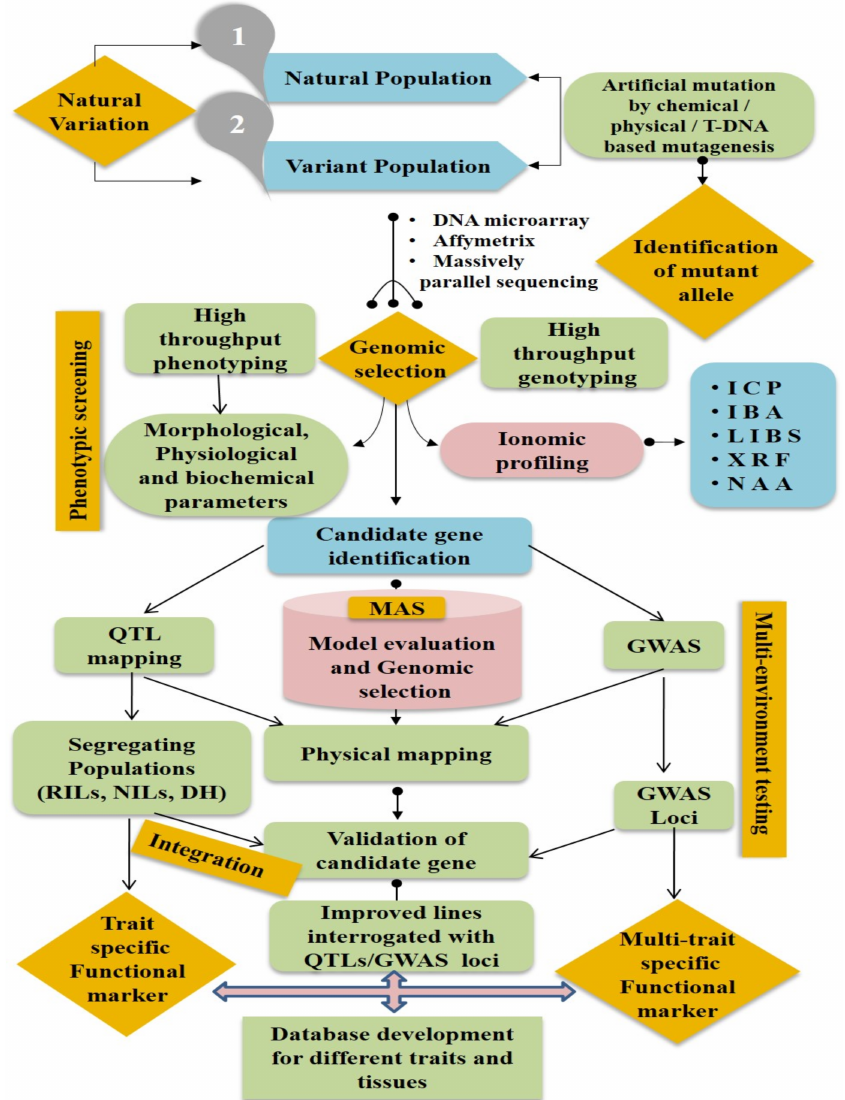
Figure 2. Quantitative trait locus (QTL) mapping and genome-wide association study (GWAS) for the identification of multi-trait specific biomarkers based on ionomic profiling and database development. RIL: recombinant inbred line; NIL: near isogenic line; DH: doubled haploid; MAS: marker-assisted selection; ICP: inductively coupled plasma; IBA: ion beam analysis; LIBS: laser-induced breakdown spectroscopy; XRF: X-ray fluorescence spectroscopy; NAA: neutron activation